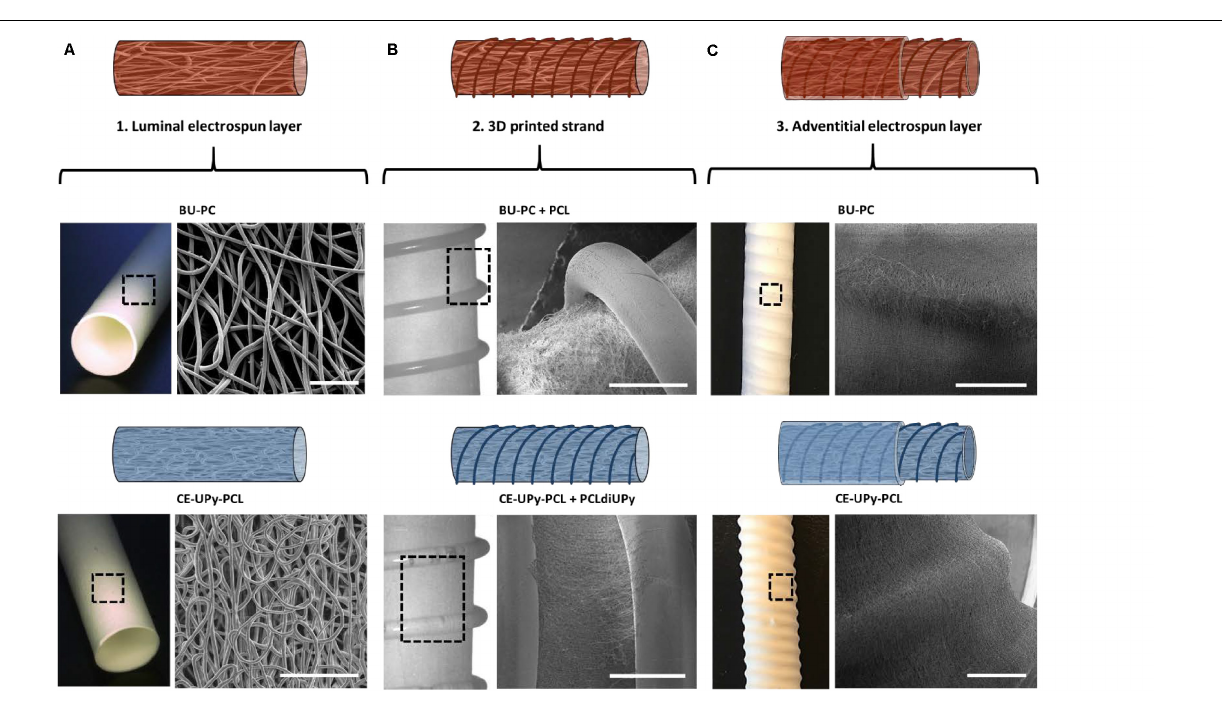
Frontiers in Materials |